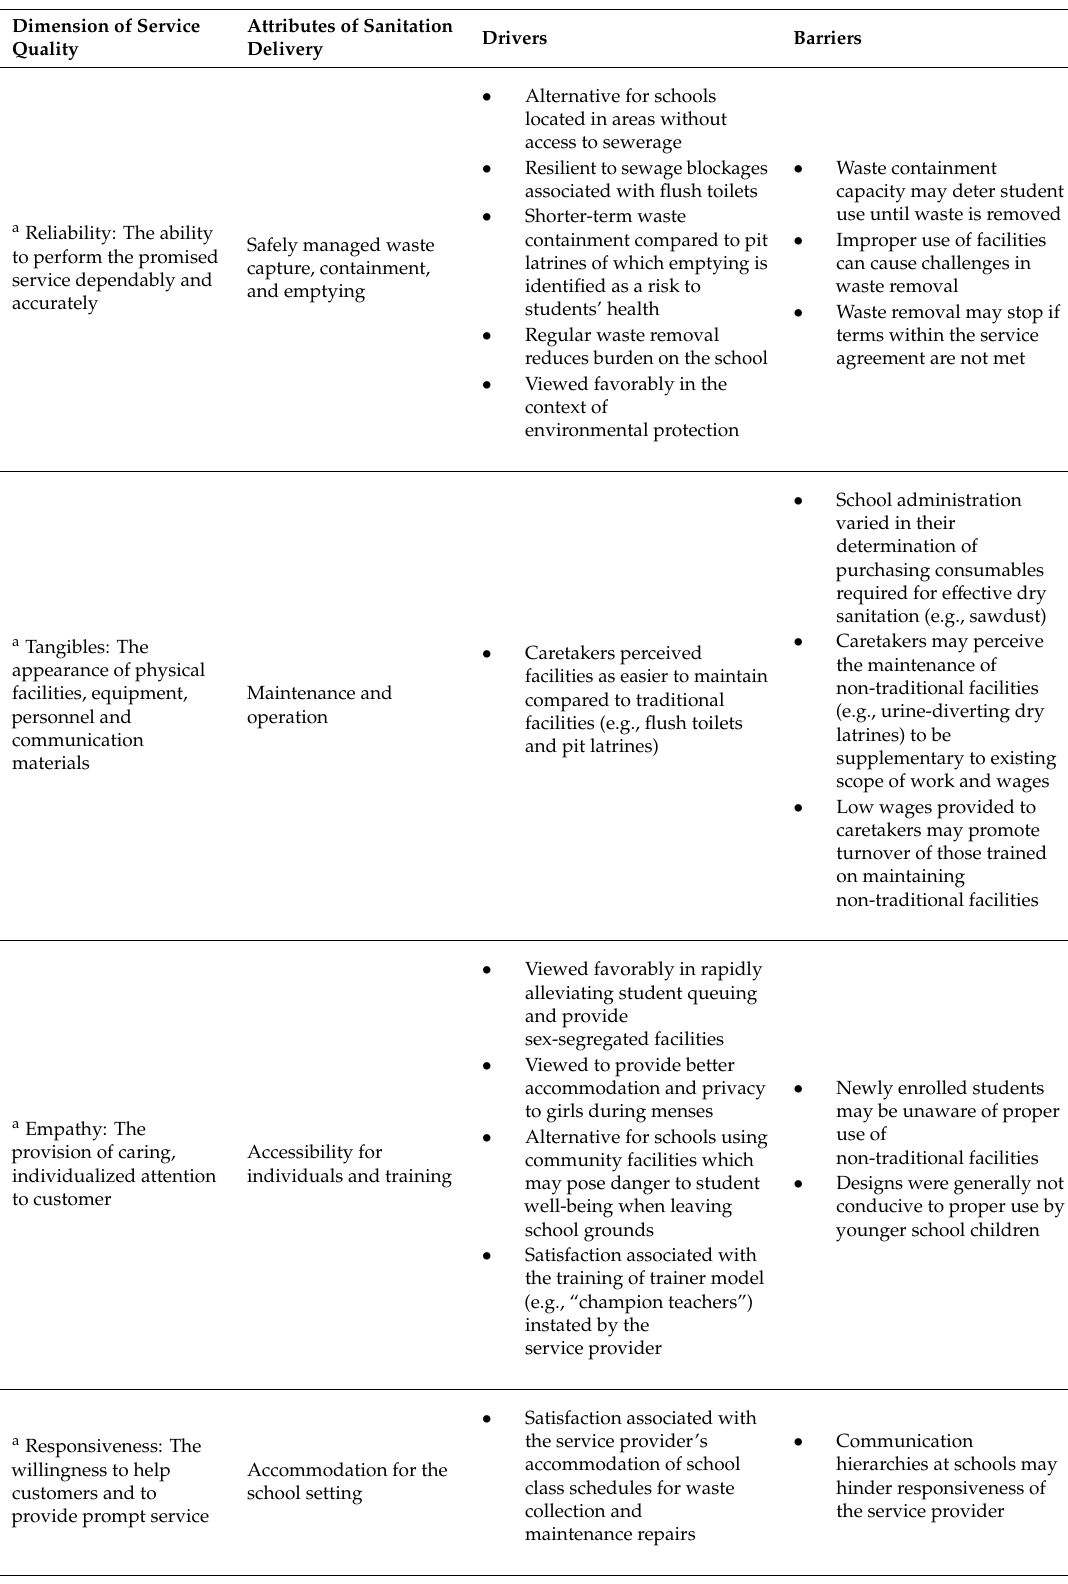
Table 2. Summary of key drivers and barriers for the implementation of private sector delivery of sanitation in trial